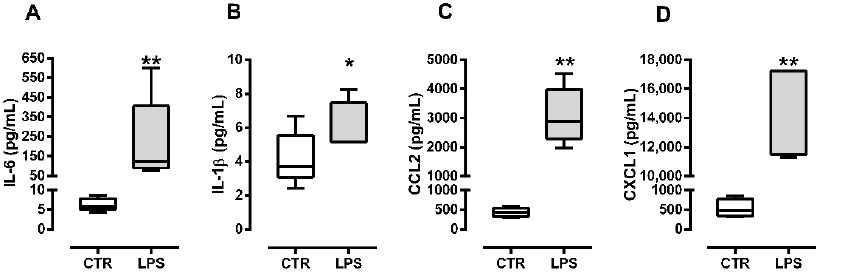
Figure 1. C2C12 myoblasts 24 h post differentiation induction respond to LPS by producing proinflammatory cytokines and chemokines. IL-6 ( A ), IL-1 β ( B ) cytokines and CCL2 ( C ), CXCL-1 ( D ) chemokines concentration in myoblast conditioned medium 72 h after first LPS stimulus (10 ng/mL). The white bar represents the control group (CTR), and the gray bar represents the LPS group. Data are expressed as median and quartiles of five independent experiments. The normal distribution was not expected due to the small sample size ( n = 5); the nonparametric test Mann– Whitney U was applied. * p < 0.05, ** p < 0.01.